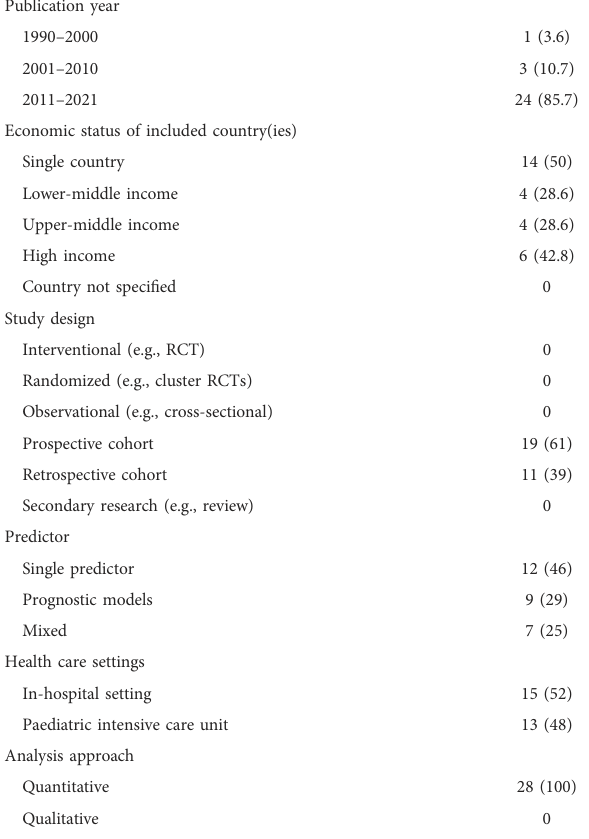
TABLE 4 Characteristics of included studies ( n